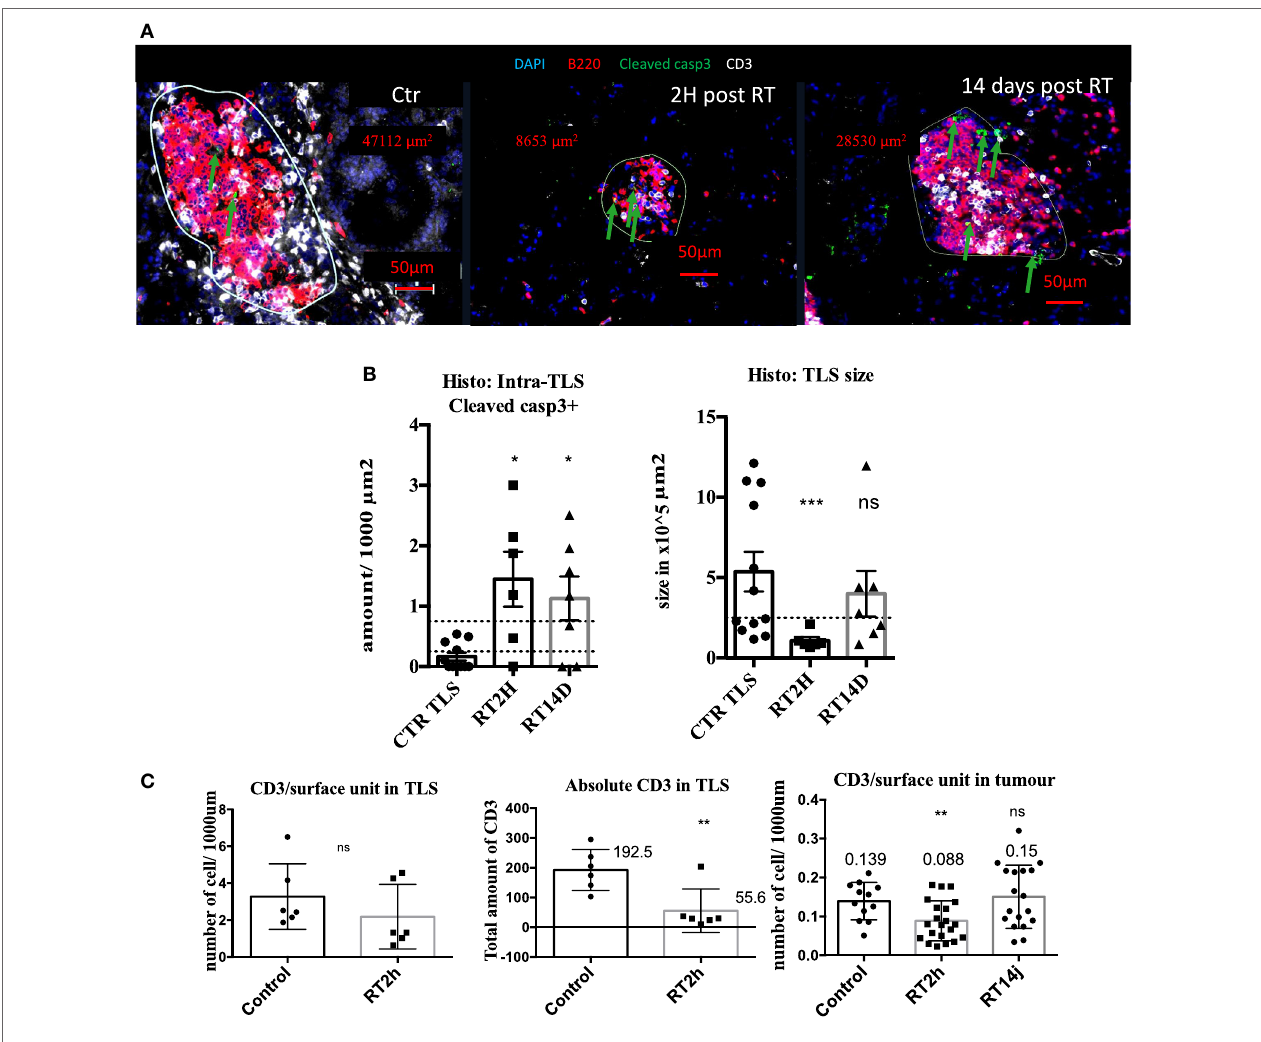
FigUre 4 | Radiation therapy (RT) increases tertiary lymphoid structures (TLS) apoptosis and their transient depletion. Apoptosis quantification measured by cleaved caspase 3 in TLS in control of KP TLS, 2 h and 14 days post-RT. TLS size was measured with Zen Zeiss software (a) . Quantification per surface unit is showed in (B) . The prevalence of CD3+ T cells was assessed in TLS and tumours to evaluate intrinsic response to RT of those cells in different compartments (c)